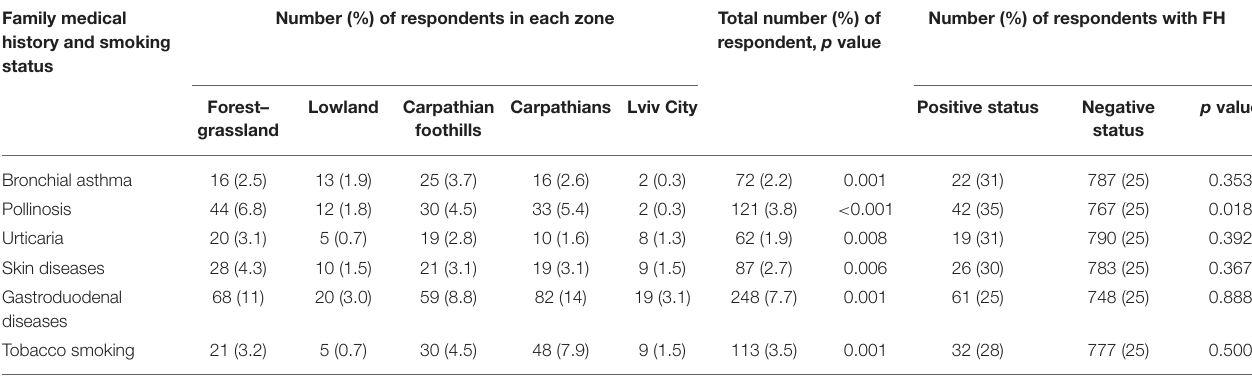
TABLE 6 | Distribution of children among geographic, climate zones, and influence of family medical history and smoking status * . Family medical history and